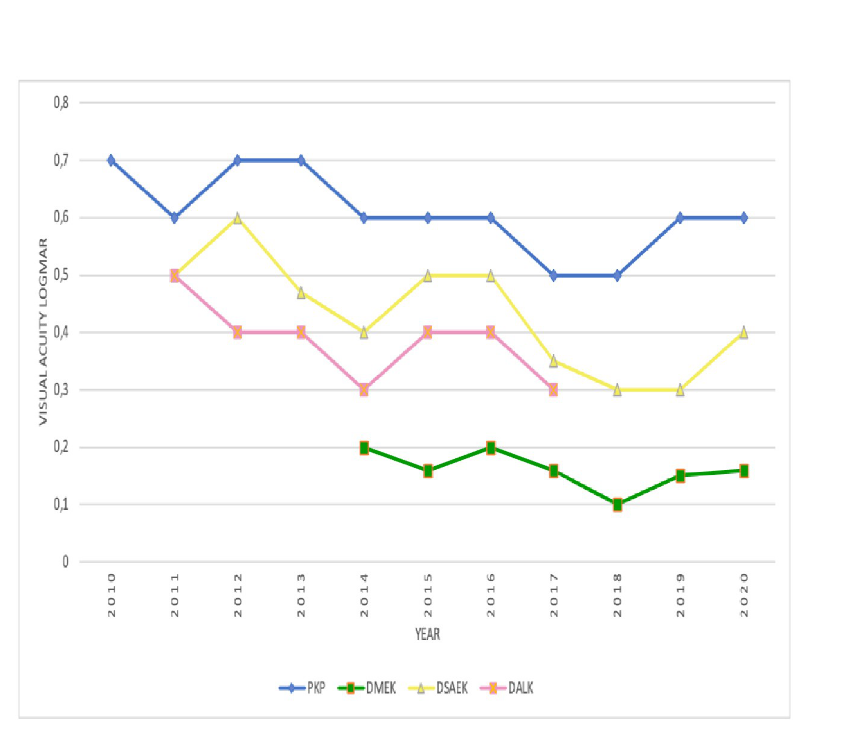
Fig 8. Changes over time in terms of mean BCVA 6 months after keratoplasty. BCVA, best corrected visual acuity; DALK, deep anterior lamellar keratoplasty; DSAEK, Descemet stripping automated endothelial keratoplasty; DMEK, Descemet membrane endothelial keratoplasty; PKP, penetrating keratoplasty.